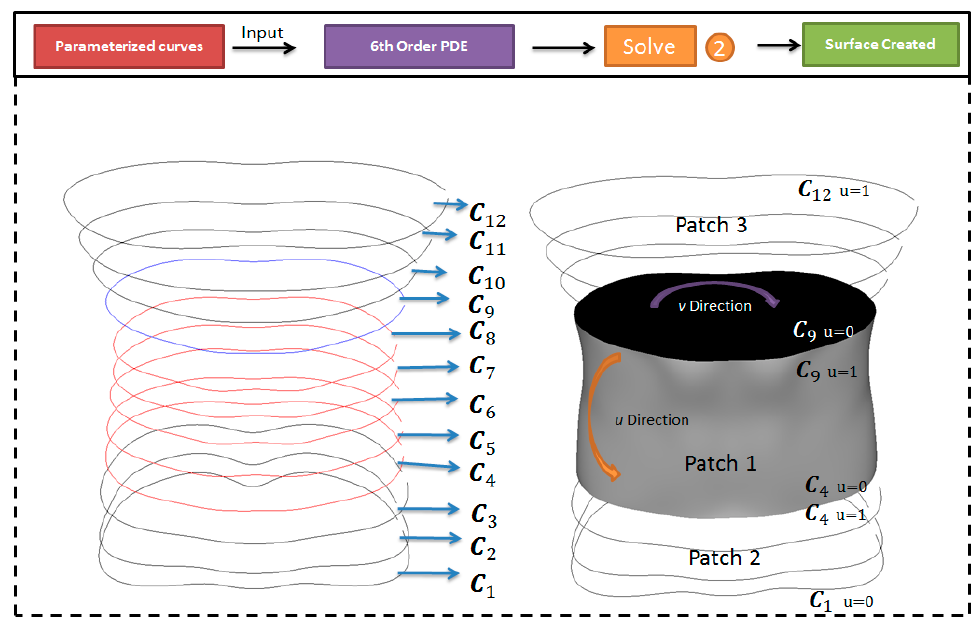
Figure 4. Surface creation example. The six curves C 4 − C 9 (red) are used to construct the PDE surface patch 1.